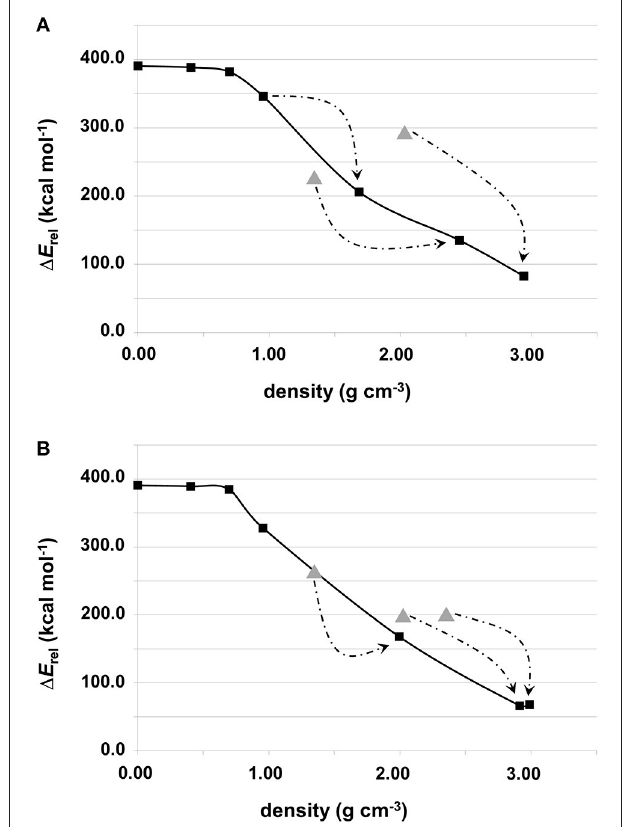
FIGURE 3 | Relative energies (in kcal mol − 1 ) of the Mg 6 Si 3 O 12 -based aggregates with respect to the bulk forsterite Mg 2 SiO 4 crystal as a function of their density. Values are normalized with respect to the four Mg 2 SiO 4 units present in the crystalline unit cell: (A) for systems shown in Figure 1 ; (B) for systems shown in Figure 2 . Values labeled by triangles refer to compressed structures without optimizing their unit cells (see text for more details). Arrows indicate the system formed upon full geometry (i.e., atomic positions + cell parameters) optimization. The molecular nanocluster system is considered to have density 0g cm − 3 , as the lattice parameters are effectively